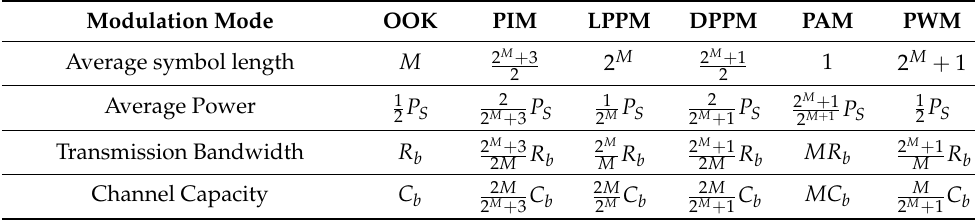
Table 1. Performance index of several modulation modes in optical